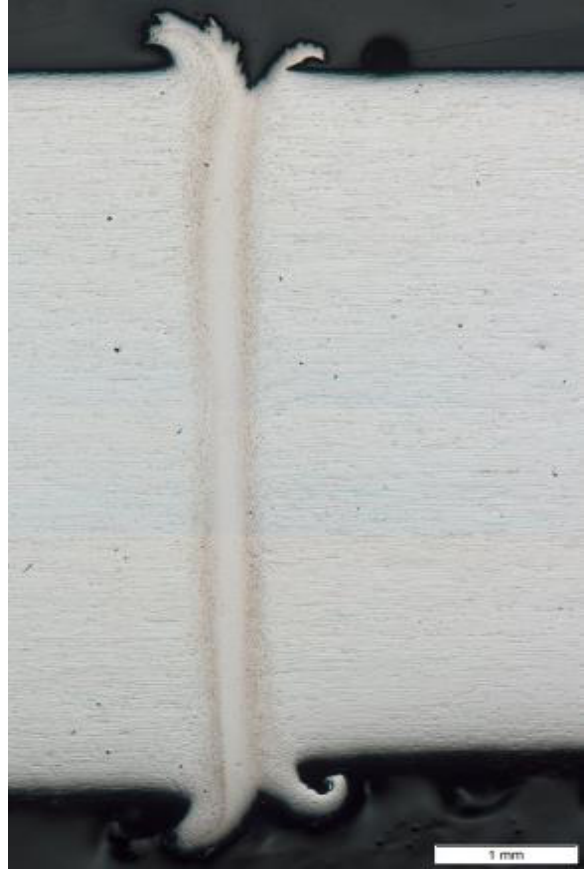
Figure 3. Macrostructure of the friction-welded joint from 316L steel after HE. Microstructure studies have revealed that for UFG 316L steel friction-welded joints, the heat-affected zone (HAZ) has a dual character of microstructure. Therefore, in HAZ. The low-temperature HAZ is a zone of partial plasticized material, where